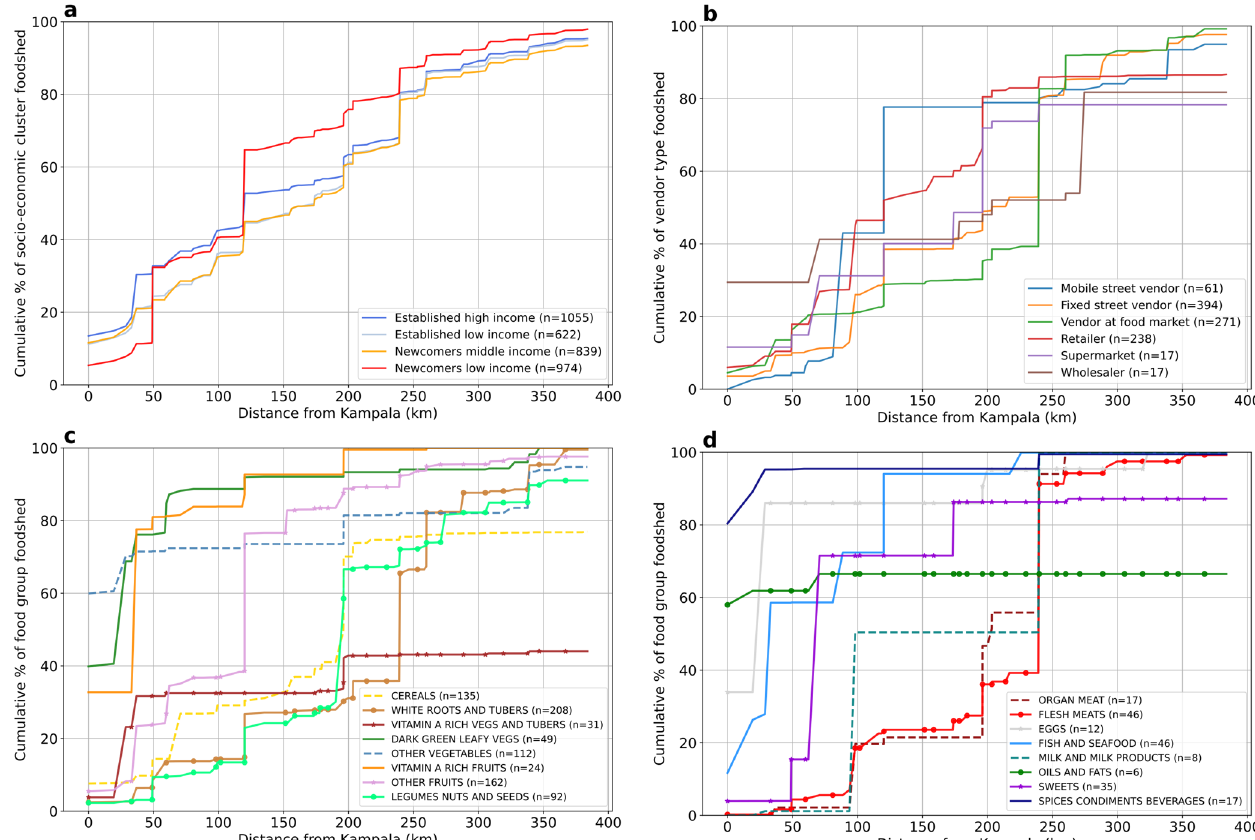
Fig. 3 Cumulative contribution to the foodshed by distance from Kampala. a Shows the cumulative distance from Kampala of the foodshed for different socio-economic groups of consumers in Kampala. b Shows the cumulative distance from Kampala of the foodshed for different vendor types. c Shows the cumulative distance from Kampala of the foodshed for the 8 plant-based food groups de fi ned by FAO (2010). d Shows the cumulative distance from Kampala of the foodshed for the 8 non-plant-based food groups de fi ned by FAO (2010). Values for n shown in legend are based on the number of food items included in each